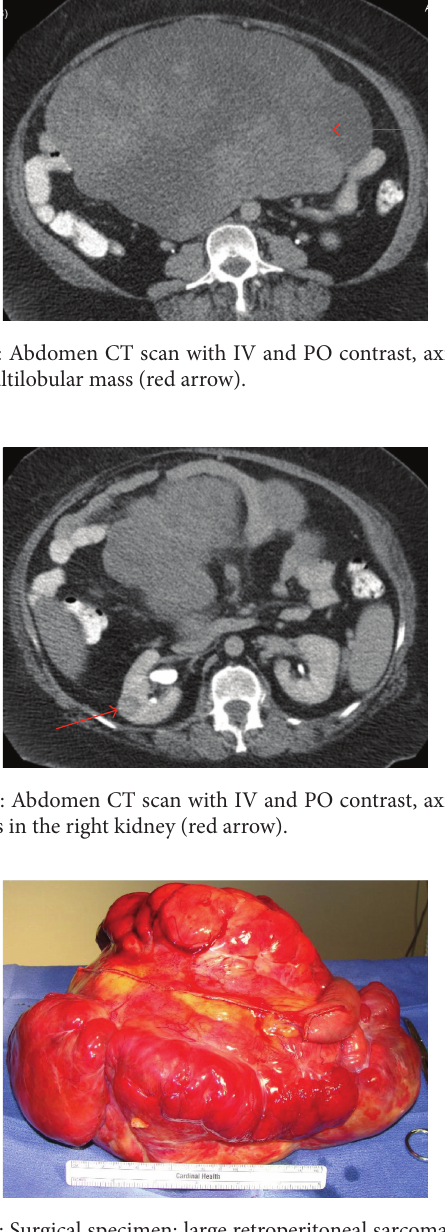
Figure 3: Surgical specimen: large retroperitoneal sarcoma involv- ing small bowel and